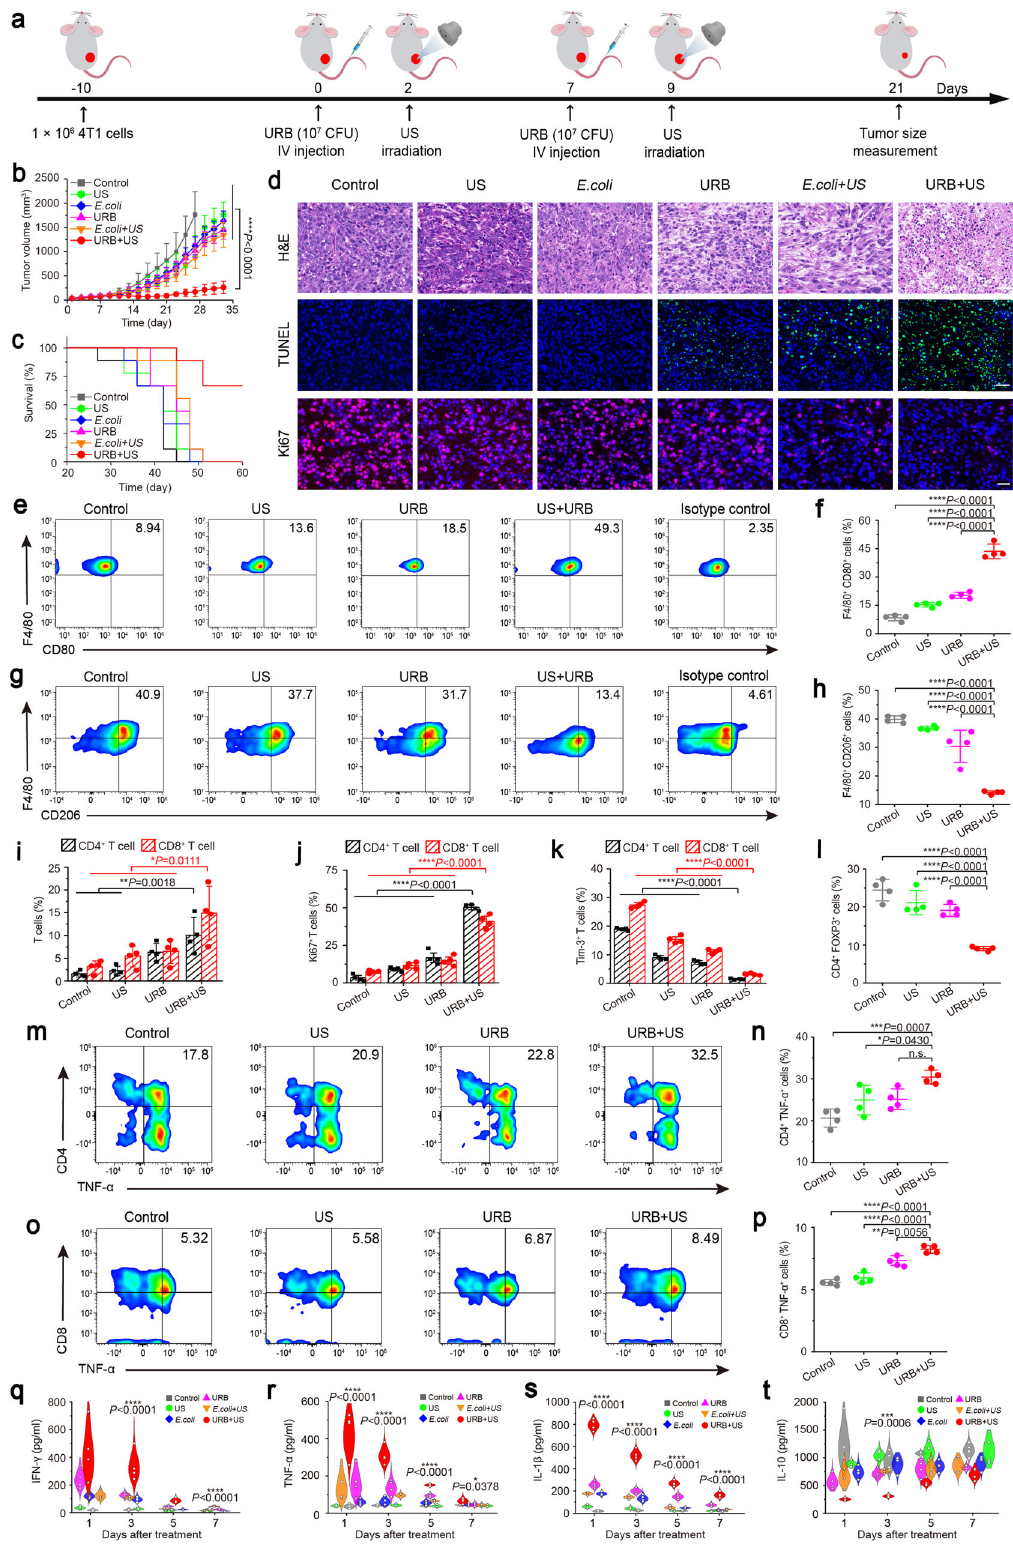
used to detect the levels of TGF- β in the distant tumors. Results showed that treatment with URB + US signi fi cantly decreased the TGF- β levels in distant tumors in comparison with other groups (Fig. 6u). Collectively, these results indicated that the URB + US treatment could trigger the systemic anti-tumor immunity to inhibit the distant tumor growth and metastasis 44 – 46